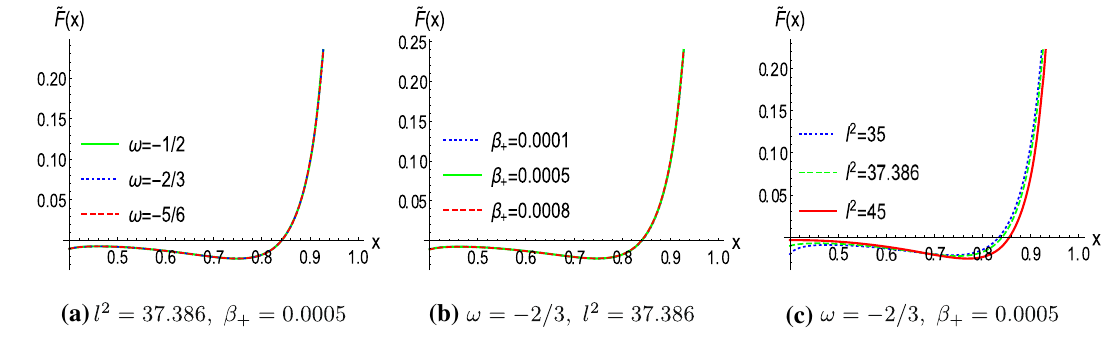
Fig. 11 Curves of ˜ F ( x ) − x with Q =